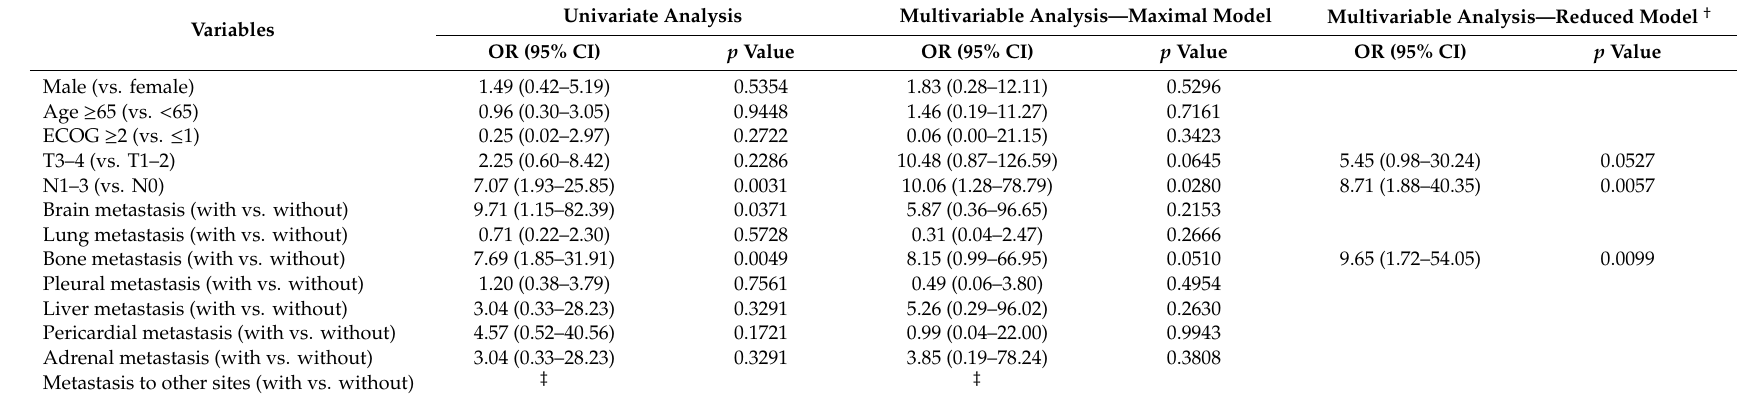
Table 2. Predicting factors for concordant EGFR mutation detected in liquid / tissue